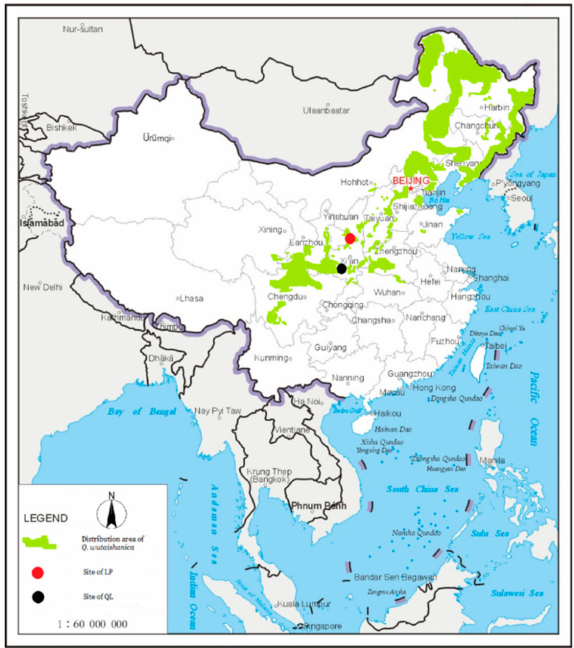
Figure 1. Distribution range of Quercus wutaishanica forest in China. LP means the site of Loess Plateau, QL means the site of Qinling Mountains. The distribution of Quercus wutaishanica forest outside China is not